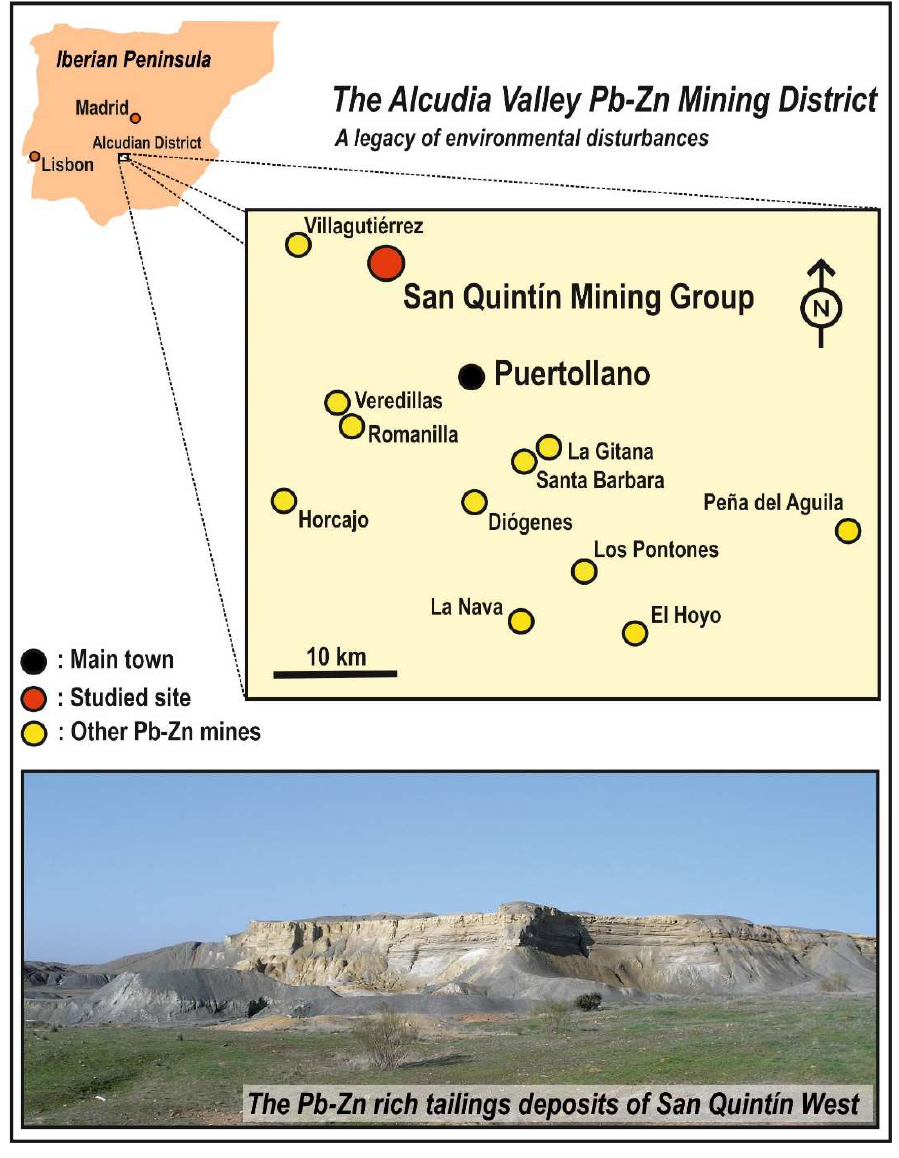
Figure 1. Location of the San Quintín Mining Group and the Alcudian Mining District in the Iberian Peninsula, and general view of the tailings deposits from San Quintín West.